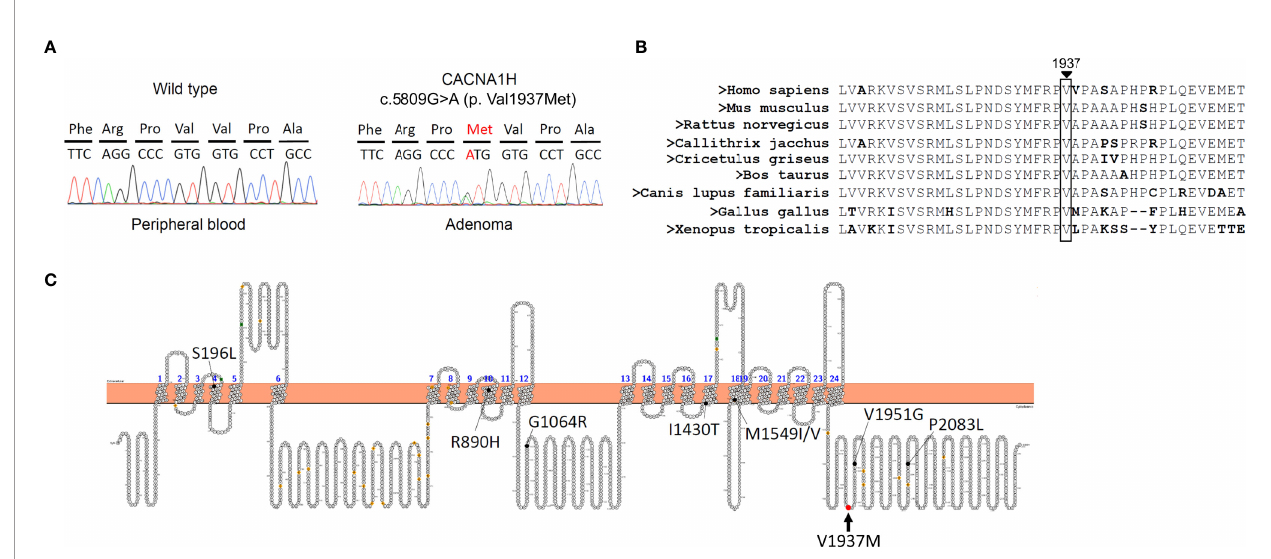
FIGURE 1 | A somatic mutation in CACNA1H p.V1937M in aldosterone-producing nodule. (A) Results of DNA sequencing of CACNA1H in peripheral blood and aldosterone-producing nodule. CACNA1H p.V1937M mutation was noted in the nodule but not in blood cells. (B) The region marked by an arrow in wild-type CACNA1H indicates the location of valine (symbol Val or V) 1937. Amino acid V1937 is conserved across different species. (C) The structure of human CACNA1H Cav3.2 calcium channel. The red arrow indicates the replaced amino acid of the CACNA1H p.V1937M variant identi fi ed in this study, which is located in the C- terminal domain.